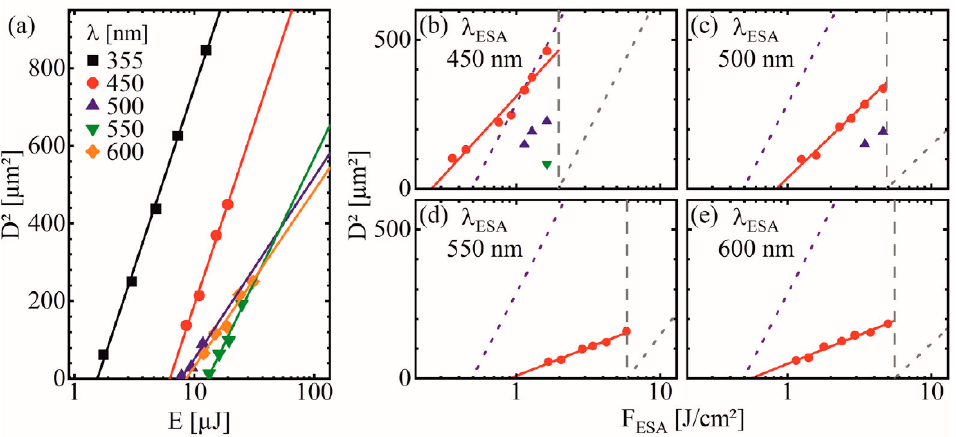
Figure 3. ( a ) Semilog plots of D 2 over E with the corresponding linear fits, to determine the ablation parameters E th , 2 ω f , and F th of single-beam absorption by the method of Liu [25]. The exact values at the utilized λ are listed in Table 1. ( b – e ) Semilog plots of D 2 over F ESA for ESA based ablation at different λ ESA with ( b ) λ = 450 nm, ( c ) λ = 500 nm, ( d ) λ = 550 nm, and ( e ) λ = 600 nm. For excitation, different F pump values of 0.2 J/cm² ( ⁃ ● ⁃ ), 0.1 J/cm² ( ▲ ), and 0.02 J/cm² ( ▼ ) were used. F ESA was varied below their respective F th (Table 1), indicated by the vertical dashed line. The values for F pump = 0.2 J/cm² were linearly fit to D 2 = 0. The diagonal dotted lines highlight the F th fits of λ = 355 nm (---) and the respective λ ESA (---) plotted in ( a ).